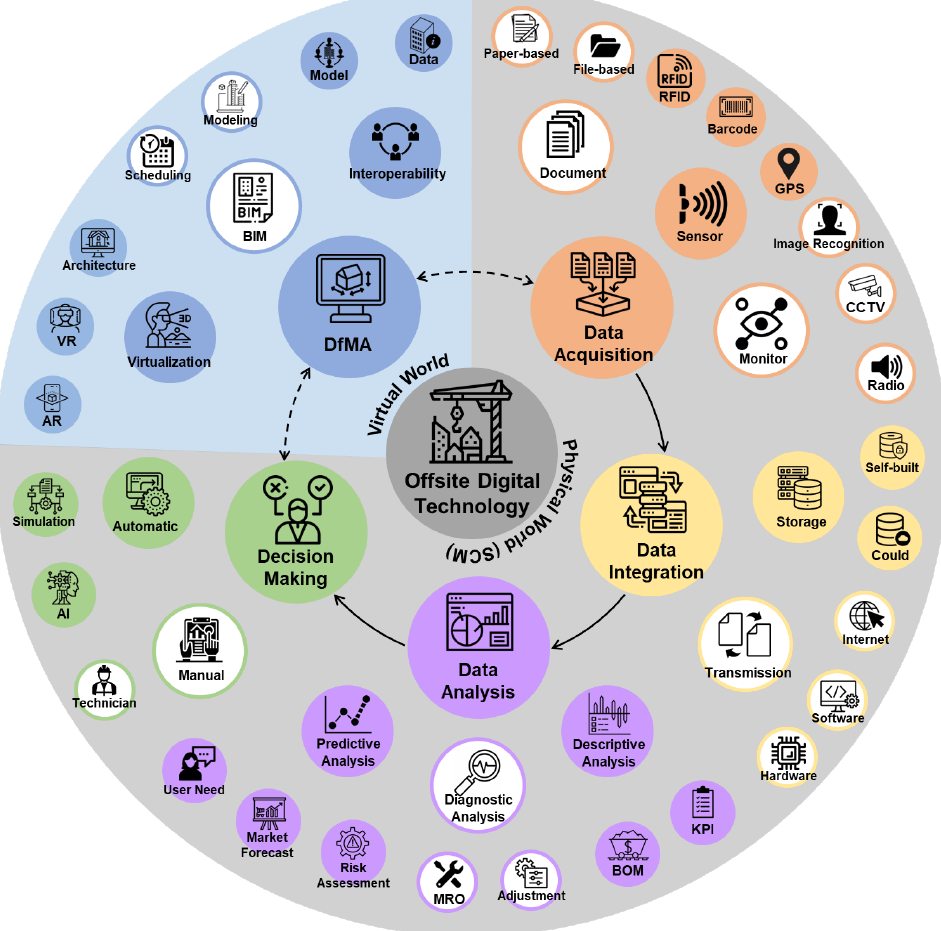
Figure 3. Digital technology for offsite construction.